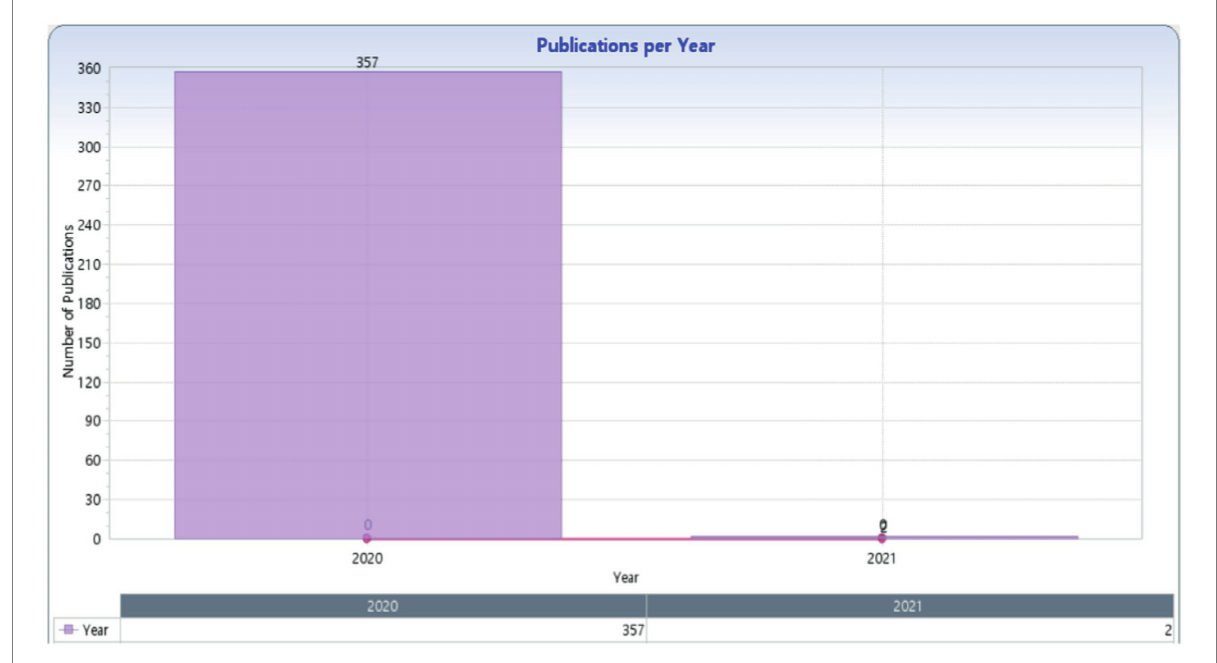
FIGURE 1 Publications per year in Web of Science (KnowledgeMatrix Plus